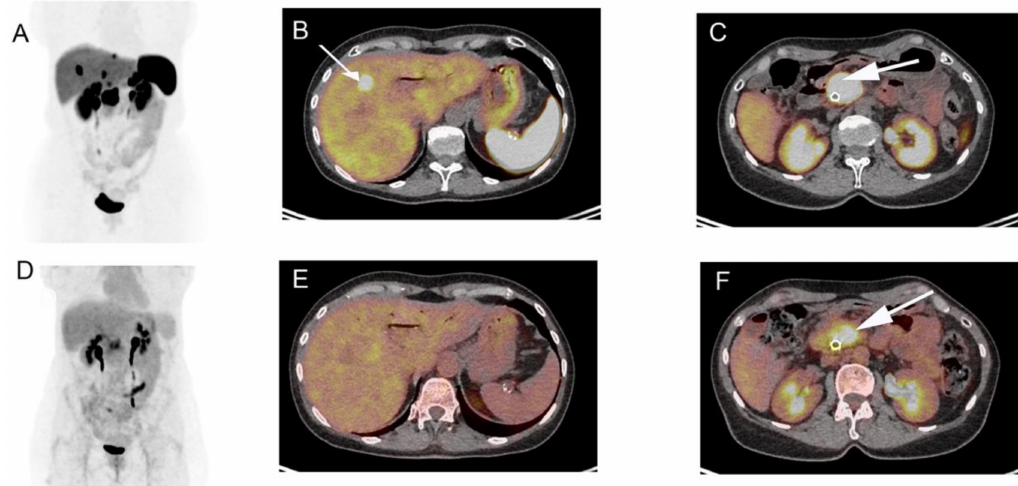
Figure 1. A 45-year-old woman presenting with a large lesion of the pancreatic head, with an initial diagnosis of grade 2 neuroendocrine tumor (NET G-2) after histopathologic analysis of biopsy specimens. Pre-therapeutic 68 Ga-DOTATOC. positron emission tomography/computed tomography (PET-CT) maximum intensity projection image ( A ) and axial fused PET-CT images ( B , C ) showed multiple liver lesions ( B , arrow) and high uptake by pancreatic lesion ( C ). The 18 F-FDG PET-CT ( D – F ) demonstrated high focal uptake only in the central region of the pancreatic tumor ( F ) and no pathological liver uptake ( E ), highlighting tumor heterogeneity. Finally, histopathologic analysis of surgical specimens revealed a NET G-3 with Ki-67 index of 22% and confirmed liver